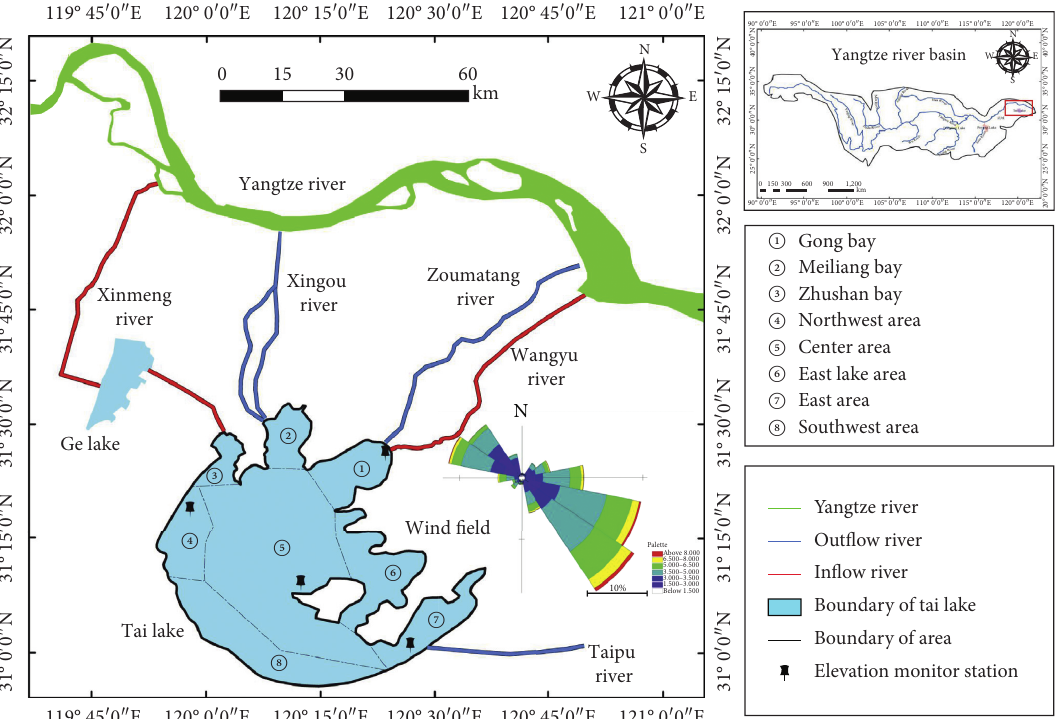
Figure 1: Map showing the location of water diversion from the Yangtze River to Tai Lake project. An inset map shows the location of the study area within